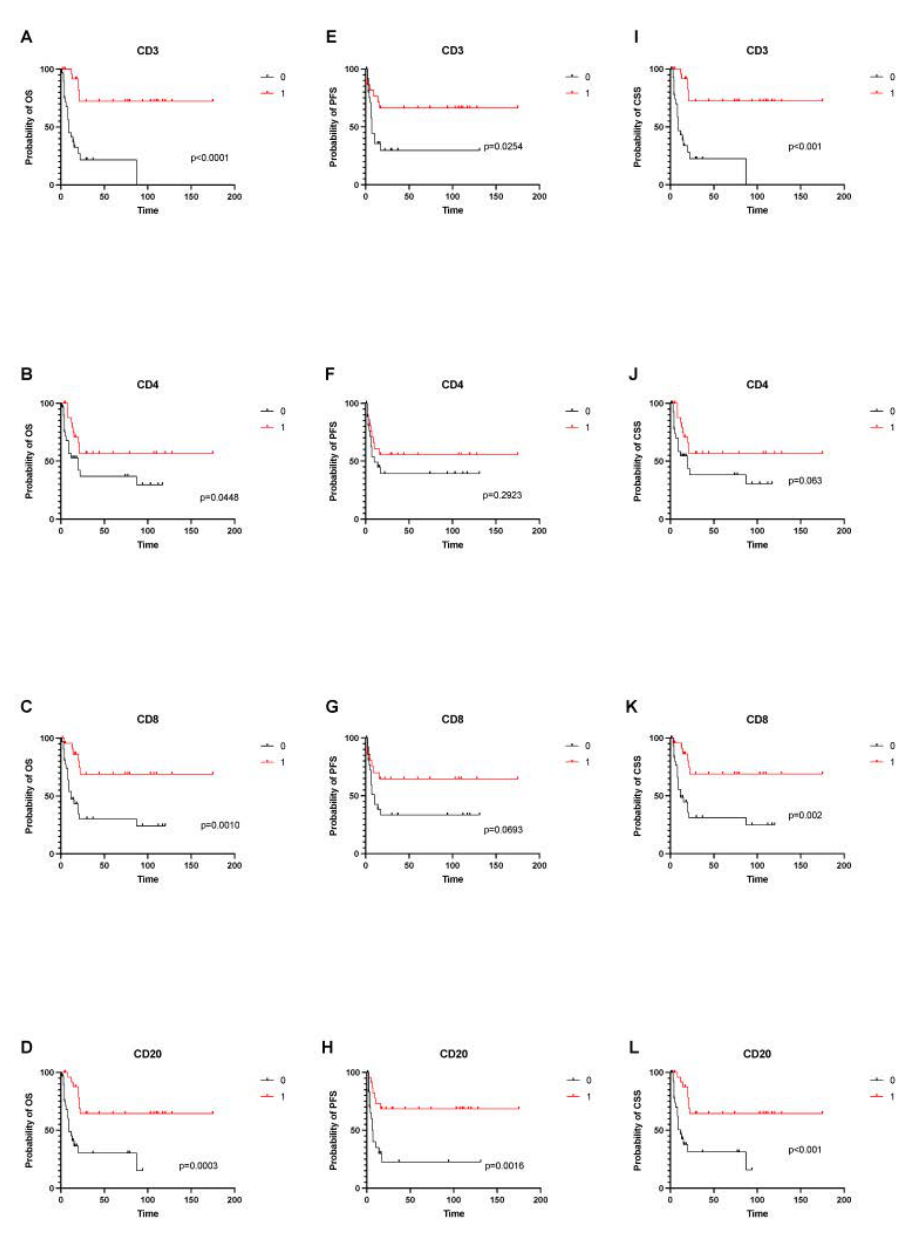
Figure 2. Overall, cancer-specific and progression free survival depending on tumor-infiltrating immune cells. ( A – D ) shows OS depending on infiltration status of CD3, CD4, CD8 and CD20 cells. ( E – H ) shows PFS depending on infiltrations status of CD3, CD4, CD8 and CD20 cells. ( I – L ) shows CSS depending on infiltrations status of CD3, CD4, CD8 and CD20